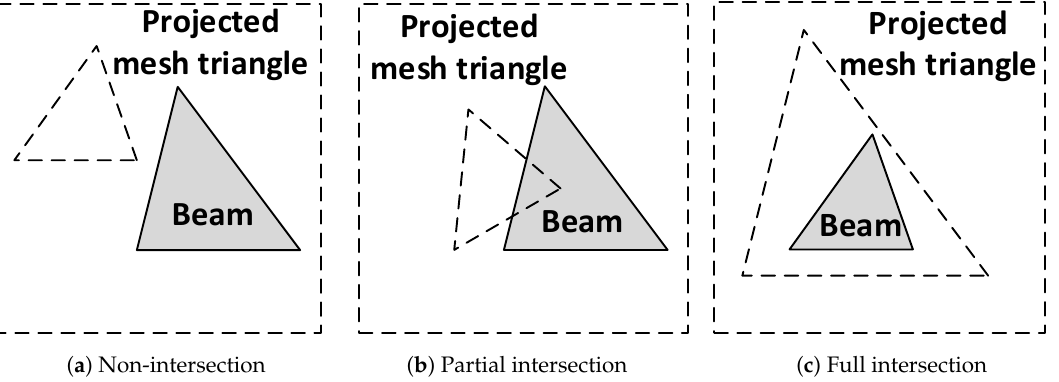
Figure 4. Three cases of intersection. Project the mesh triangle on the beam base plane, we can get the relative position between beam and mesh triangle.